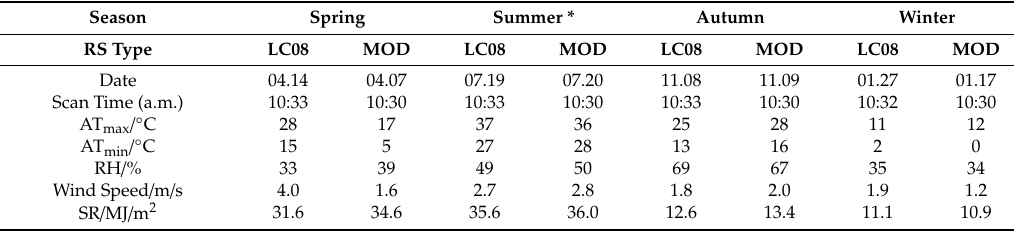
Table 6. RF model parameter list and the optimal combination of this model. Season Spring Summer *